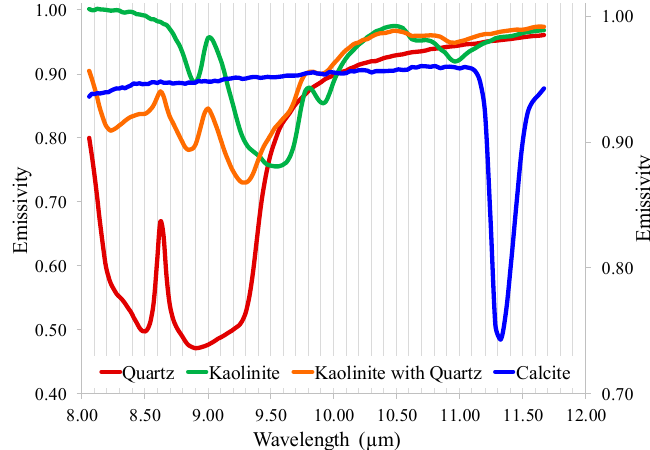
Figure 4. Emissivity spectra of pure minerals: quartz, kaolinite, kaolinite with quartz substrate (left y -axis) and calcite (right y -axis), based on [21] and resampled to the Telops Hyper-Cam spectral